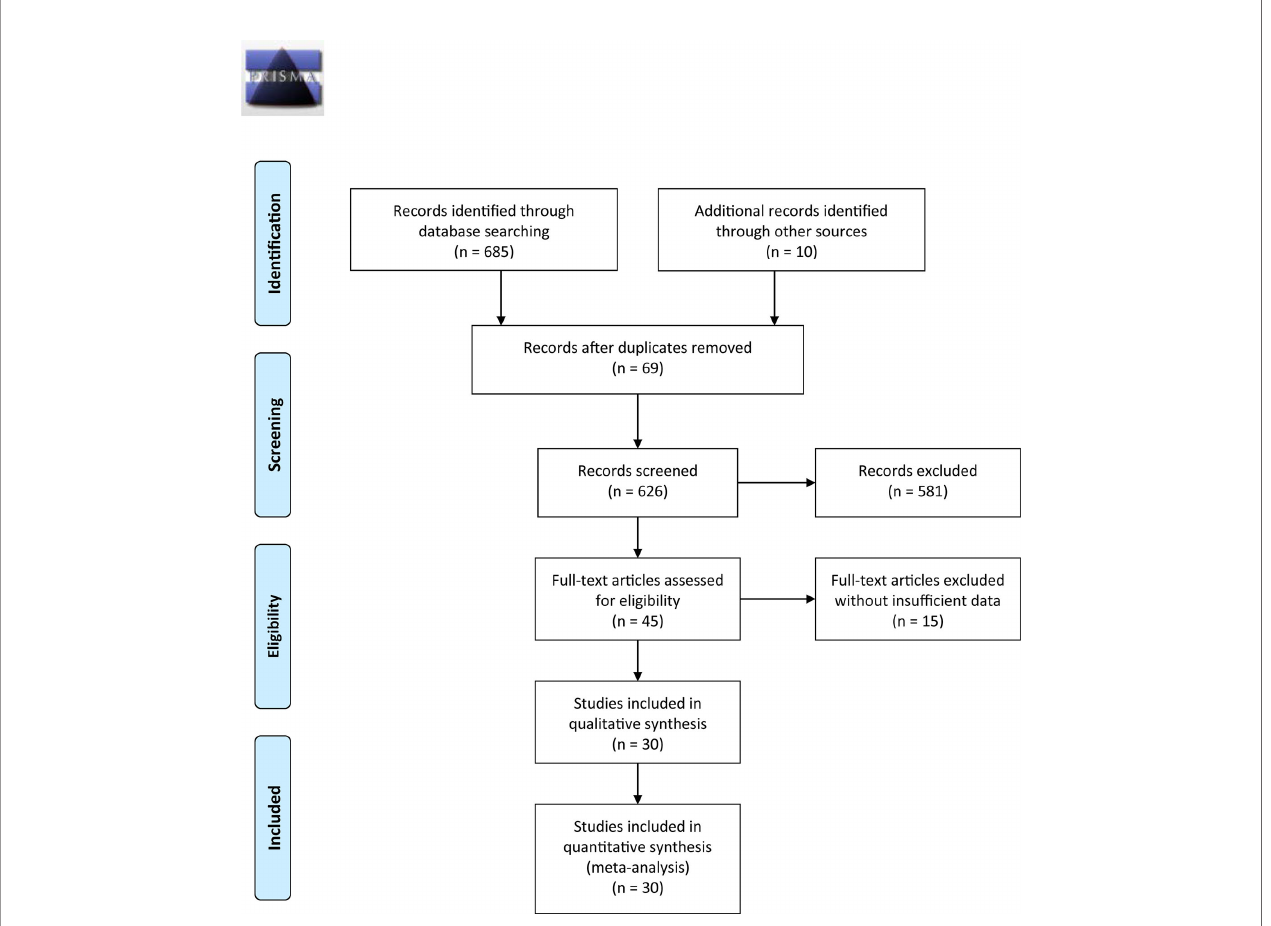
FIGURE 1 | Flow chart of the literature search and selection of